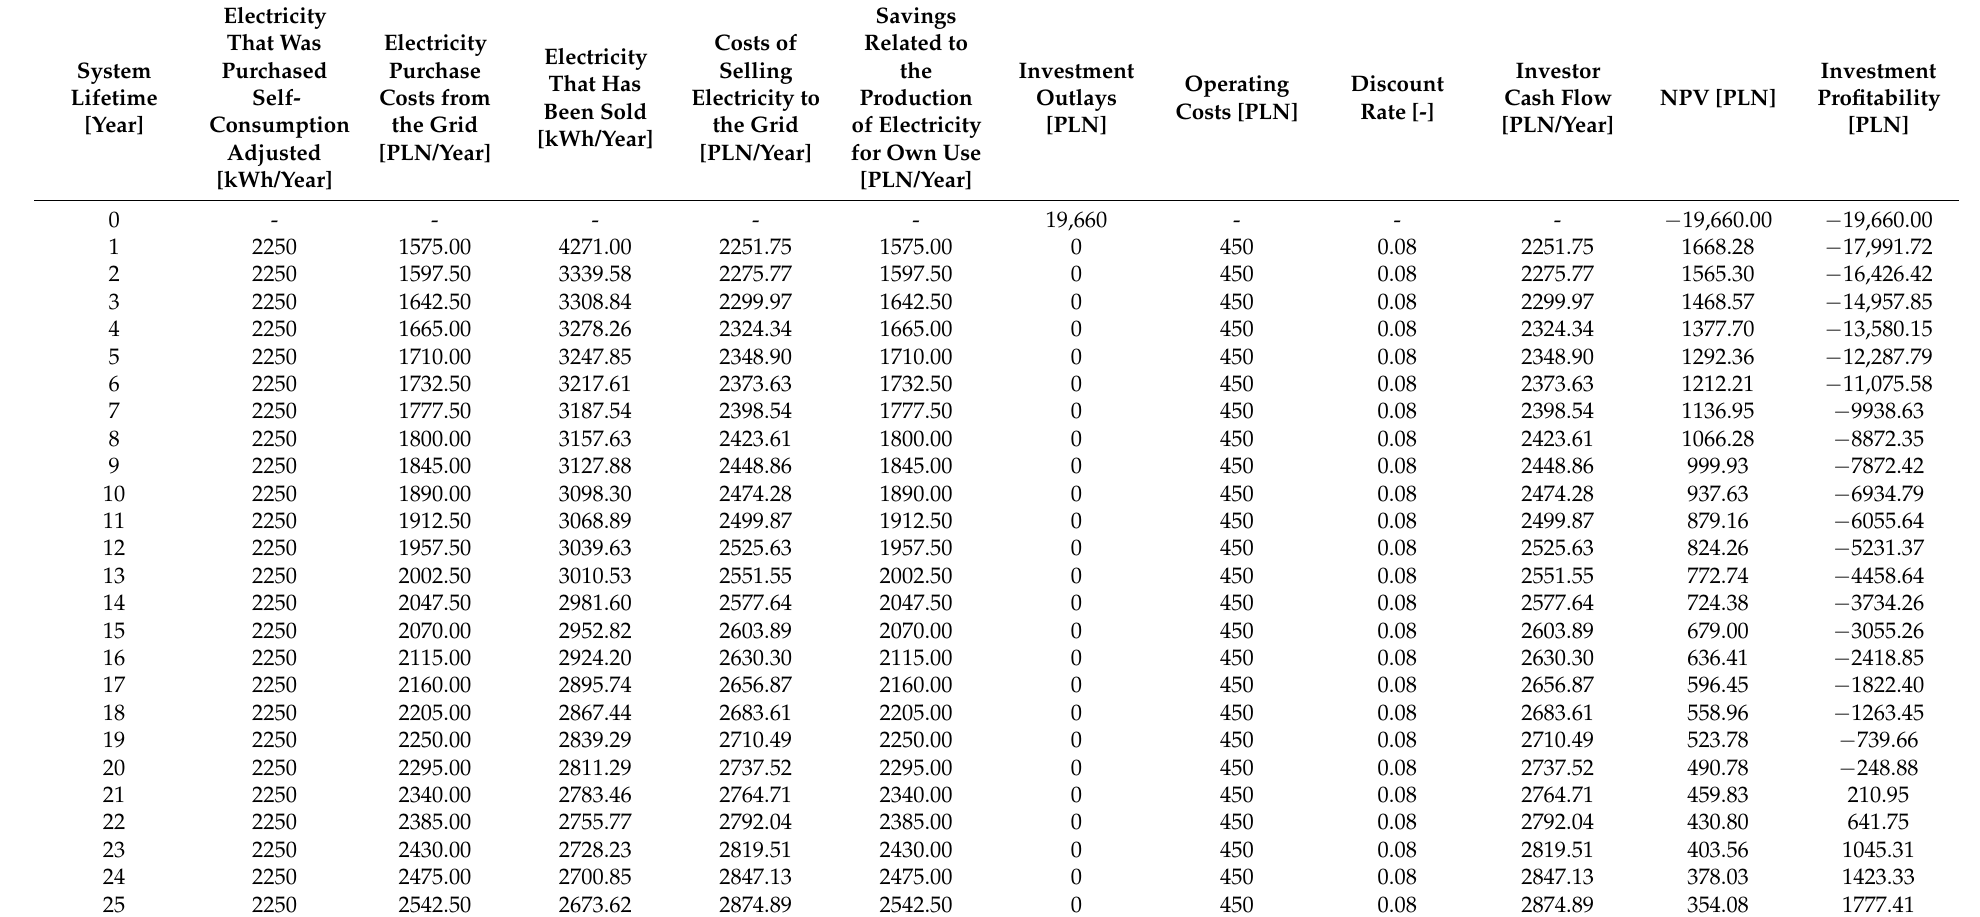
Table A6. NPV results of the PV installation for the net-billing system based on hourly prices, at a 50% self-consumption